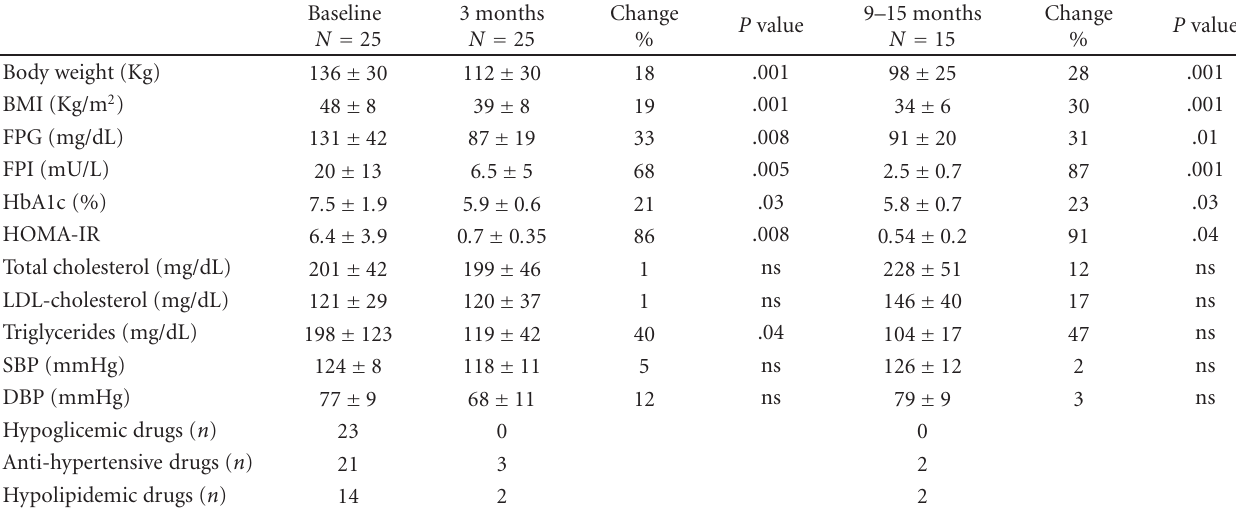
Table 1: Changes in body weight, arterial blood pressure, and main biochemical parameters following